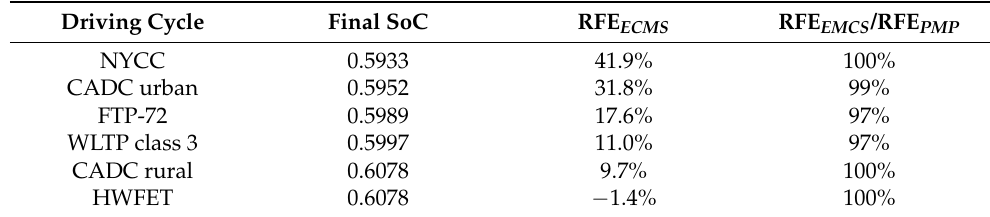
Table 5. Results of Causal ECMS-based ( Q = 1000), applied to the driving cycles listed in Table 2 in terms of Relative Fuel Economy (RFE).